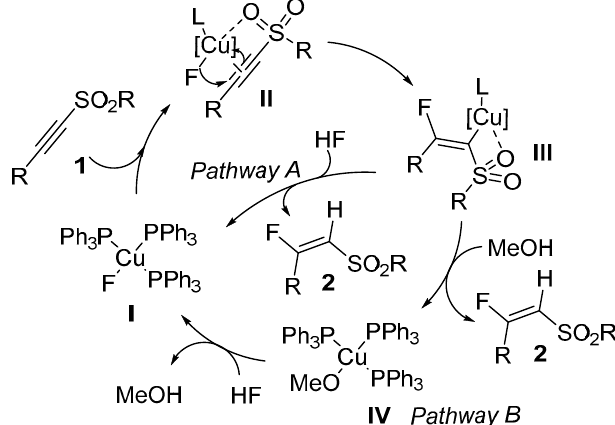
Scheme 2. Proposed reaction